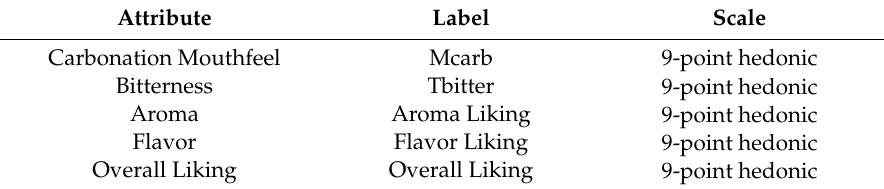
Table 2. Sensory attributes evaluated in the beer consumer test.